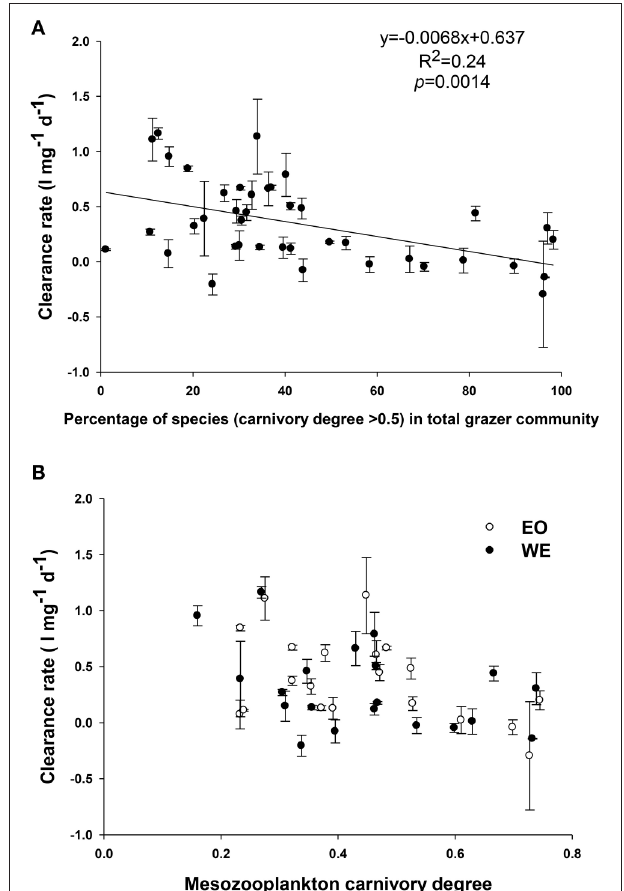
FIGURE 10 | Relationship between clearance rate and (A) percentage of mesozooplankton with a carnivory degree > 0.5 in total assemblage; (B) net carnivory degree of mesozooplankton assemblage